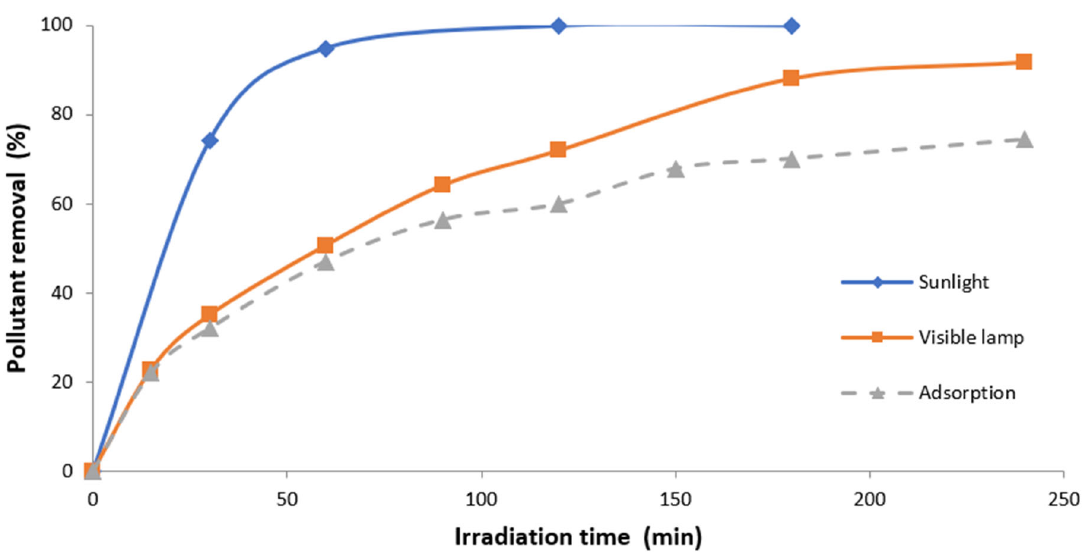
Figure 11. Pollutant in wastewater removal/degradation by adsorption/photocatalysis.